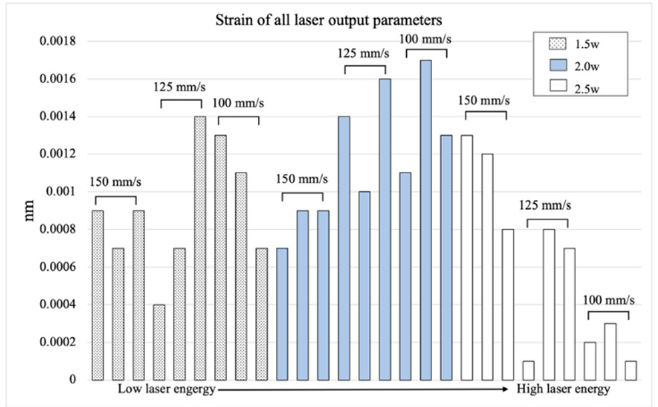
Figure 19. Strain results of all laser output parameters.